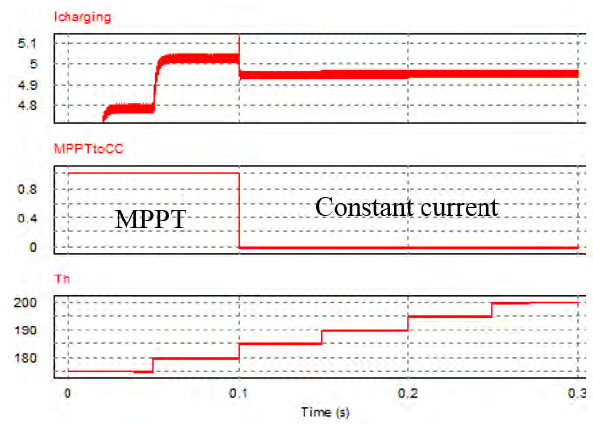
Figure 13. Output current at various hot side temperature values with constant current mode control.